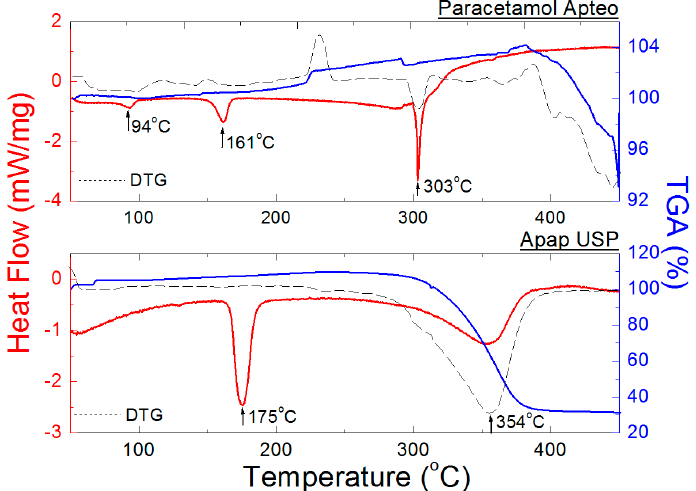
Figure 11. DSC and TGA/DTG curves of the drugs containing ACP Paracetamol Apteo and Apap